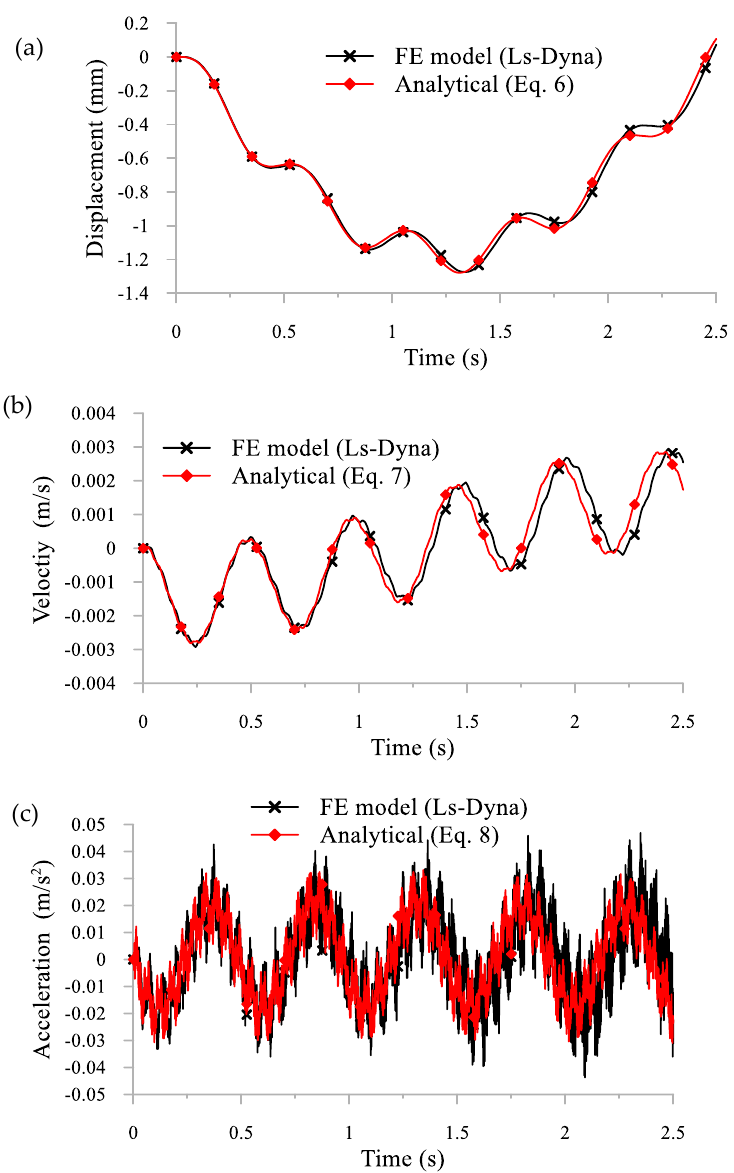
Figure 4. Dynamic responses of the bridge at the mid-span location for the FE model and analytical solution, including the ( a ) displacement response, ( b ) velocity response, and ( c ) acceleration re- sponse.